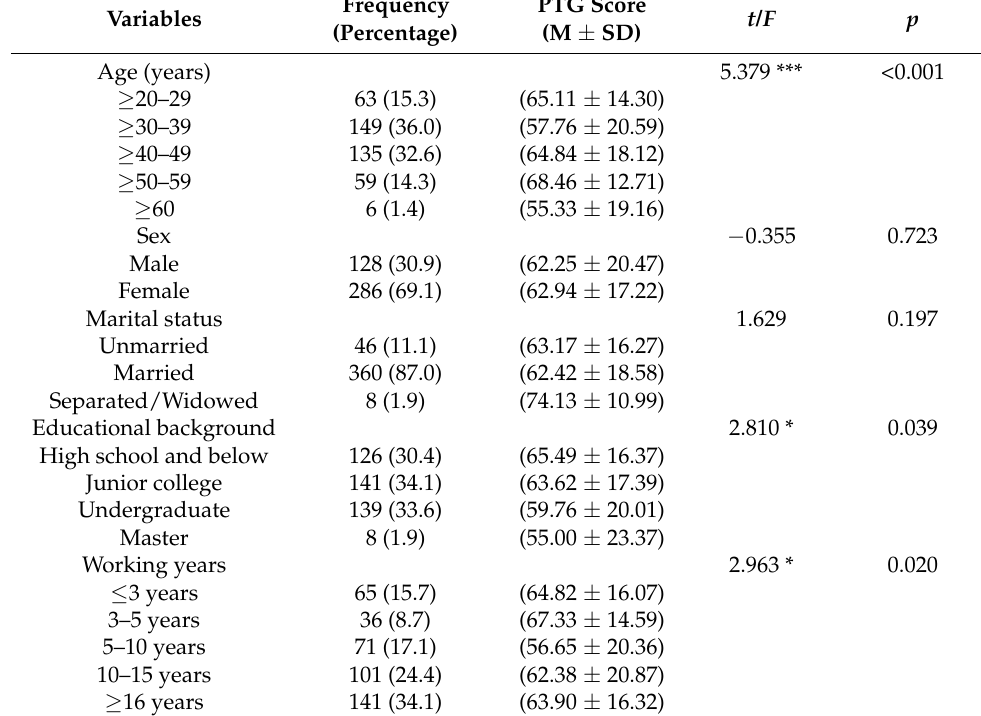
Table 1. Baseline characteristics and differences in PTG score of community workers ( N =